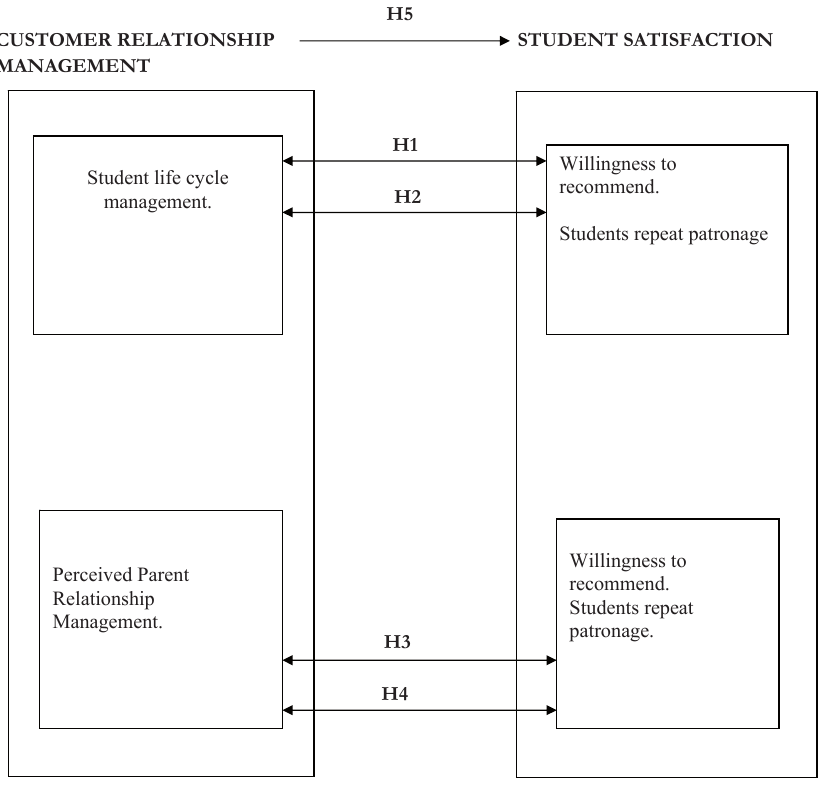
Fig. 1 - Schematic model of the study. Source: authors’